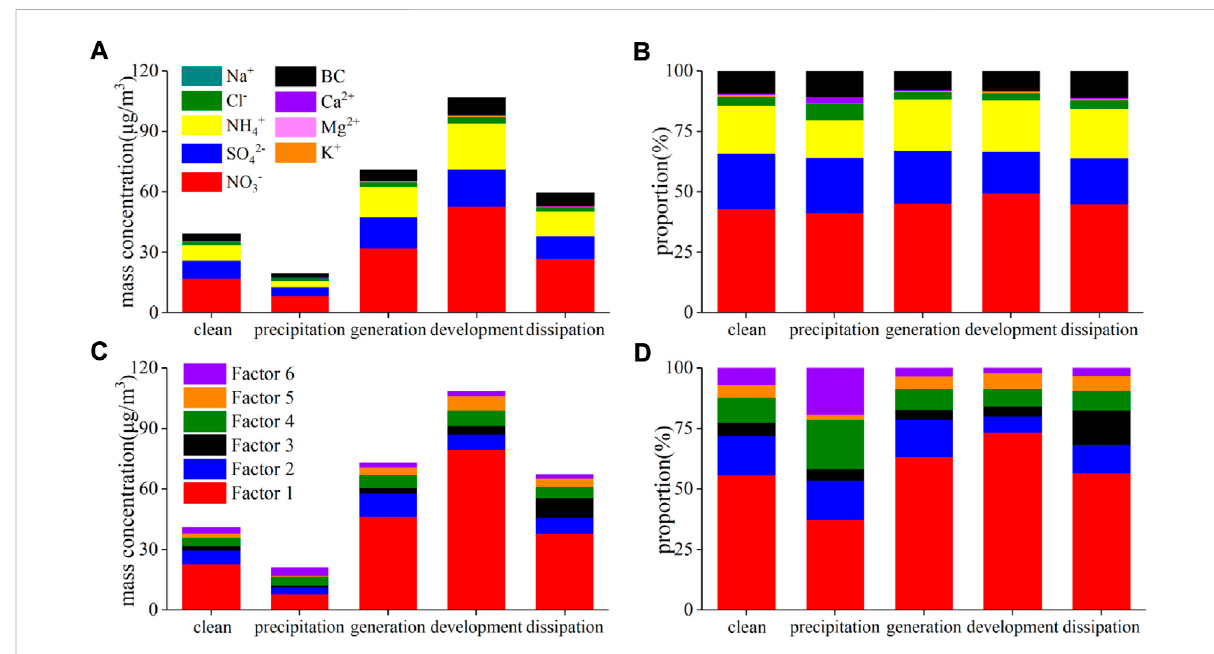
FIGURE 4 The concentration contribution and proportion of inorganic components and factors under different